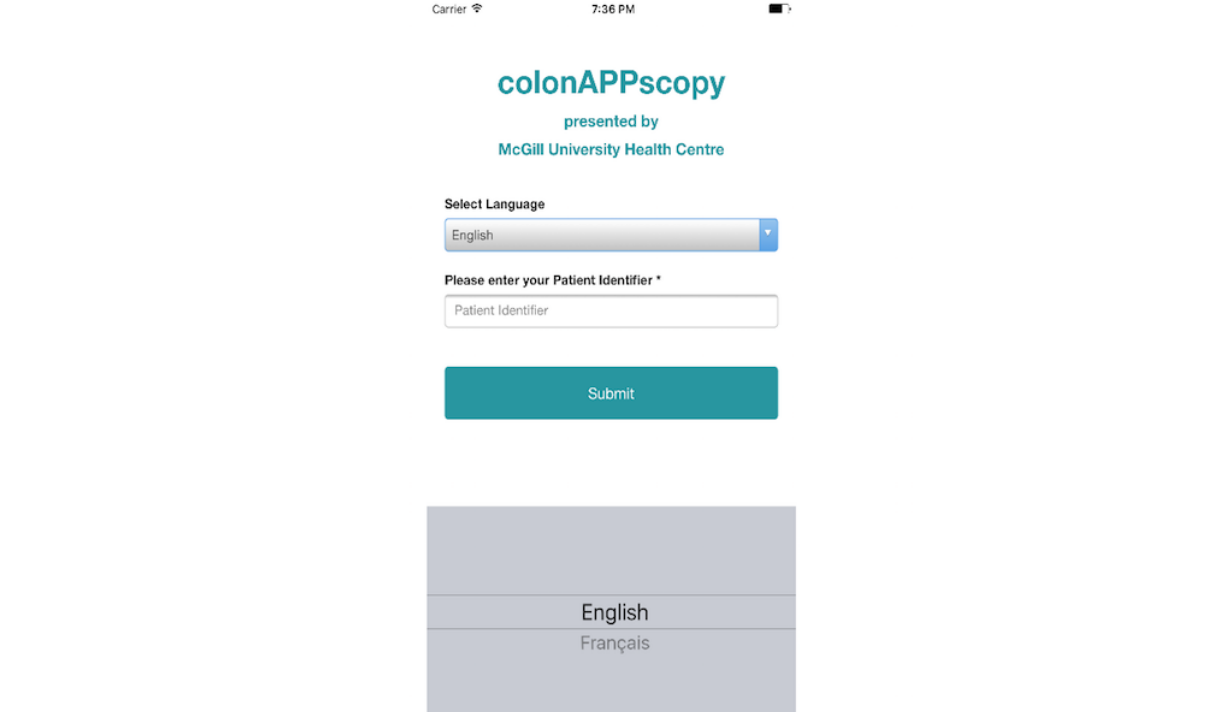
Figure 1. Screenshot of title page of